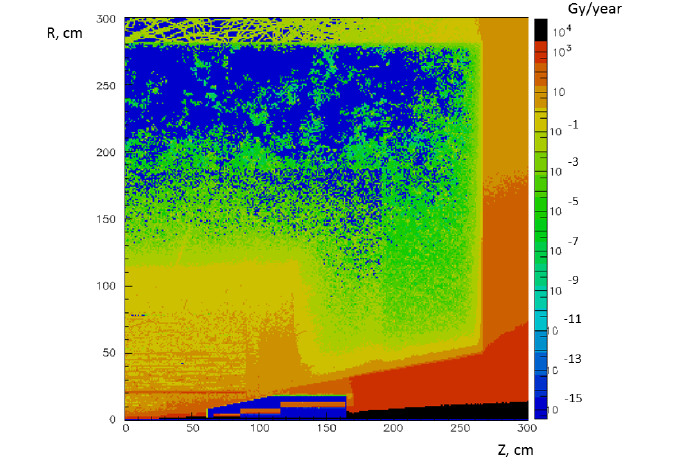
Figure 5. Absorbed dose in Gy / year.